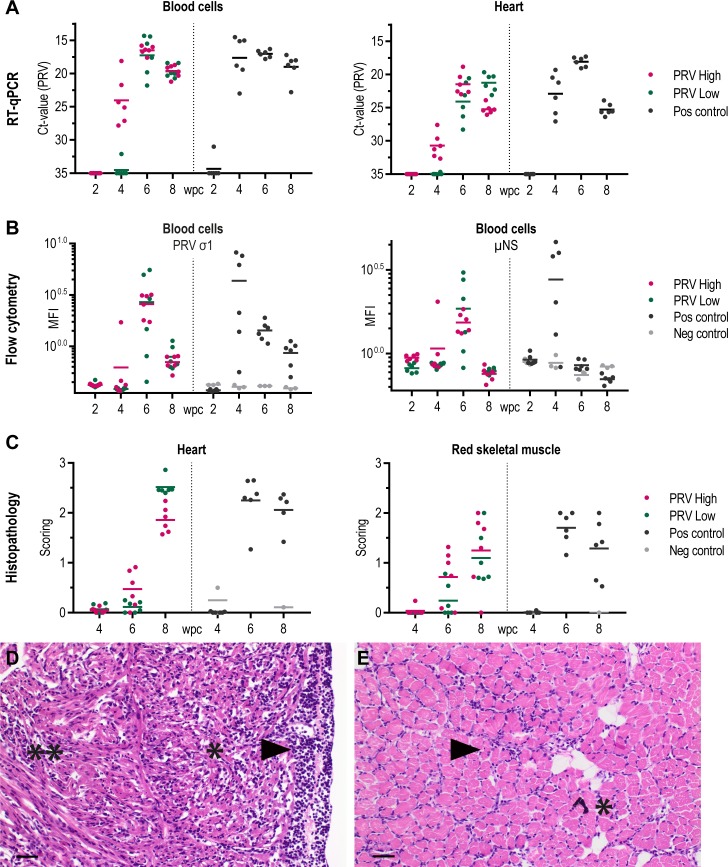
Summary cohabitant group.(A) PRV RNA in blood cells and heart measured by RT-qPCR, shown as individual and mean Ct-values from 2 to 8 weeks post challenge (wpc). (B) Amount of σ1- and μNS -protein measured by flow cytometry, shown as mean fluorescence intensity (MFI) for individual fish and group mean. (C) Histopathological score in the heart (total cardiac score) and red skeletal muscle shown as individual and group mean from 4 to 8 wpc. (D) Light microscopic images at 8 wpc in PRV-Low; (D) Heart lesions in the ventrical including severe epicarditis (arrowhead) and inflammation in the compact (*) and spongy myocardium (**) consistent with HSMI. (E) Mild inflammation in the red skeletal muscle (arrowhead), presence of melanin (*). Scale bar 20 μm. Color coding: PRV-High (red), PRV-Low (green), positive control (black) and negative control (grey). n = 6.